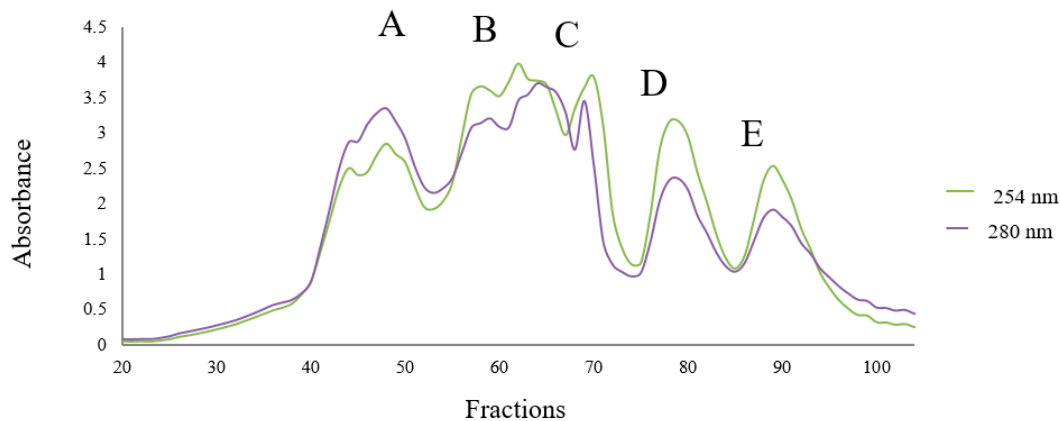
Figure 4. Size-exclusion chromatography (SEC) profile of OSPH (0.1 g/mL), using a Sephadex G-25 column.